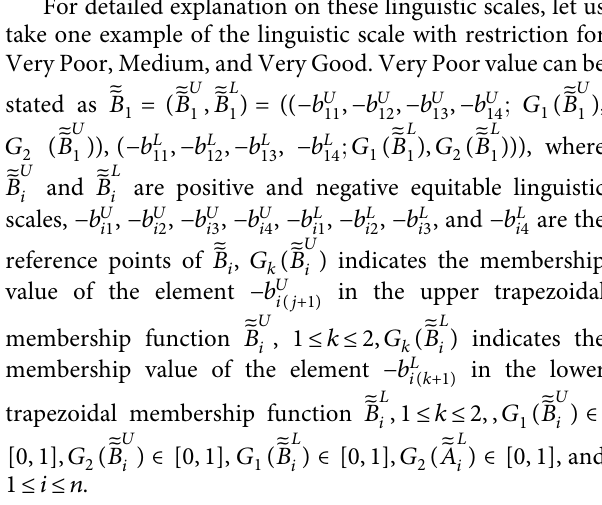
i and the lower trapezoidal membership function